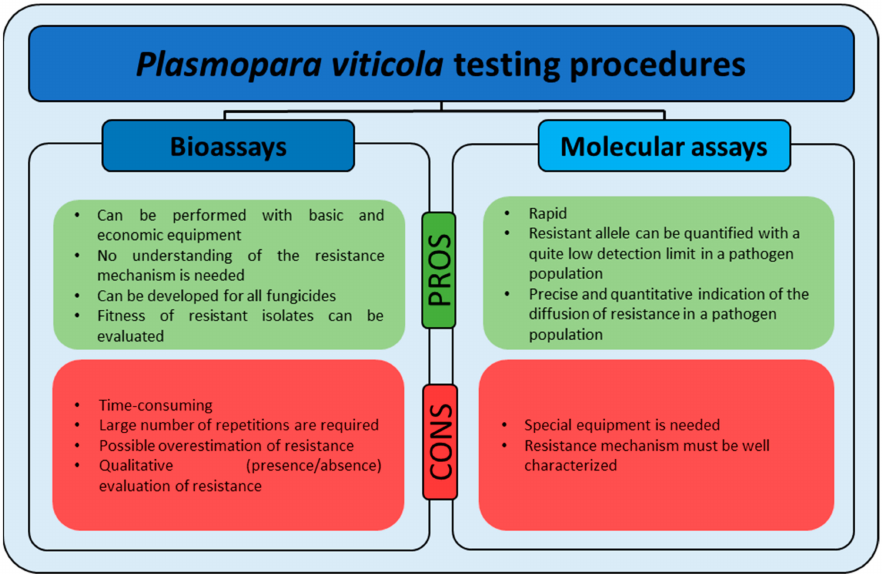
Figure 3. Advantages and disadvantages of biological and molecular assays that should be considered when choosing the testing